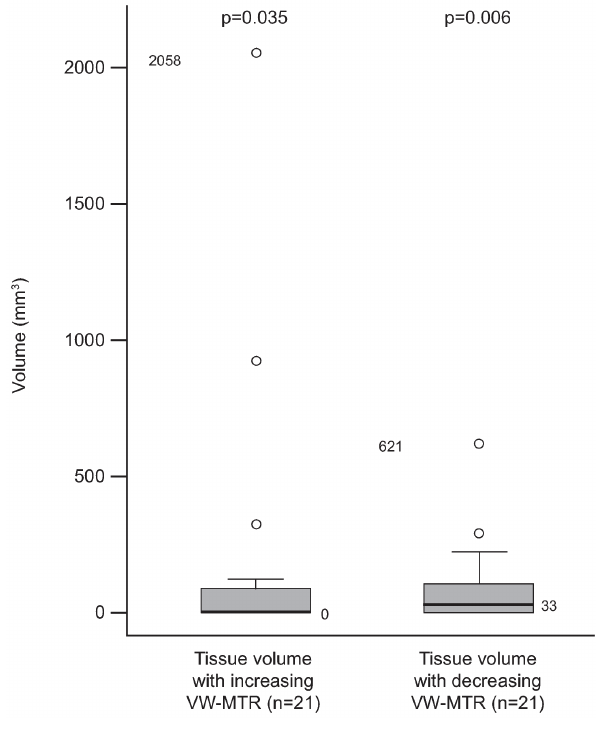
Figure 5. Difference from baseline to 24 weeks for increasing and decreasing VW-MTR in T1-LV in patients. The p-value is for the difference from zero within groups from the Wilcoxon signed–rank test with adjustment. In the box plots, the bold line represents the median; the boxes represent the middle 50% of data; the top and bottom of the box represent the third and first quartiles; the open circles are outliers. The whisker lines above and below the boxes represent the largest and smallest values that are not considered to be outliers. LV, lesion volume; VW-MTR, voxel-wise magnetization transfer ratio.